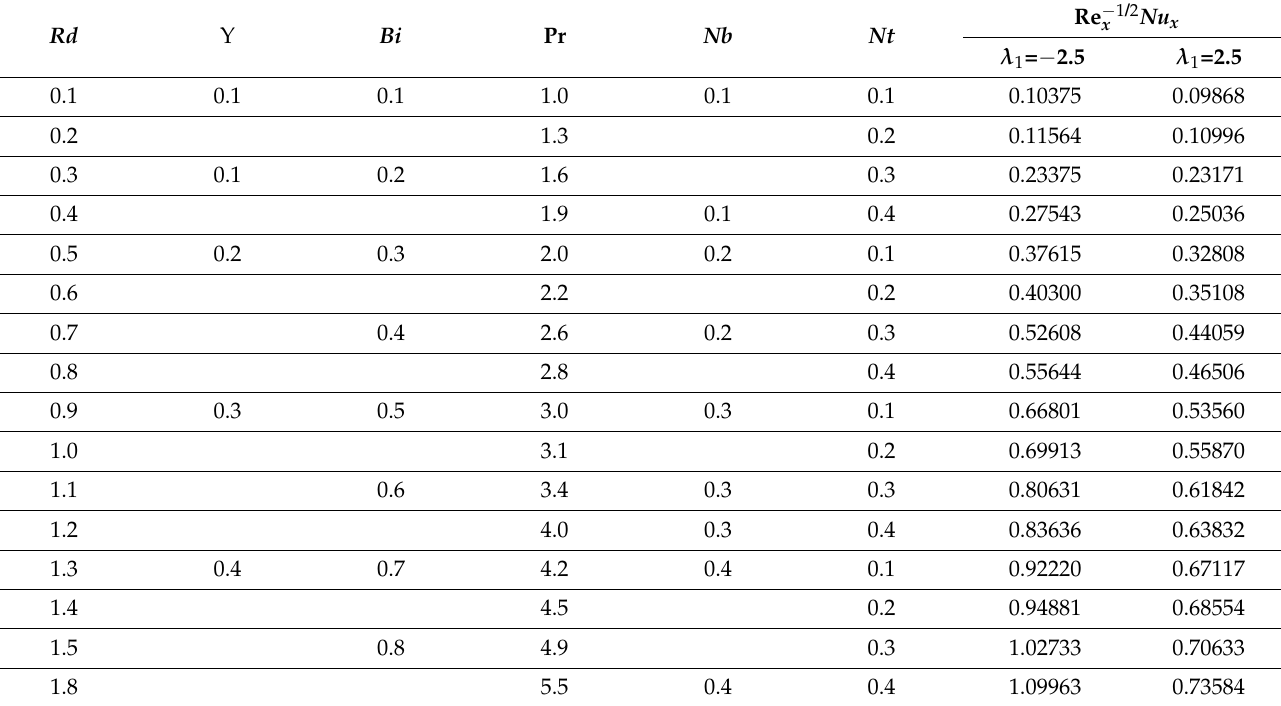
Table 4. Numerical outcomes of Re − 1/2 x Nu x numerous values of Rd , Υ , Bi ,Pr, Nb , Nt .